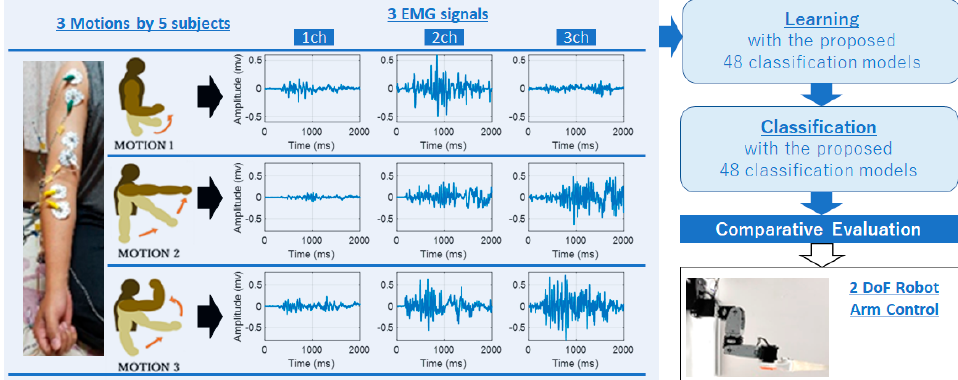
Figure 1. The proposed system for electromyography (EMG) controlled robotic arm.